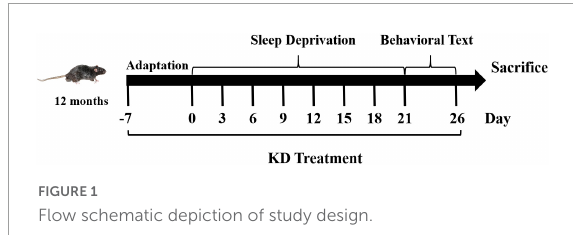
FIGURE1 Flow schematic depiction of study design.